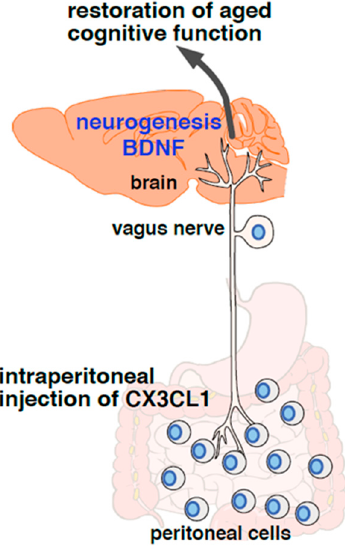
Figure 1. Crosstalk between peritoneal cells and the brain via the afferent vagus nerve. Intraperito-